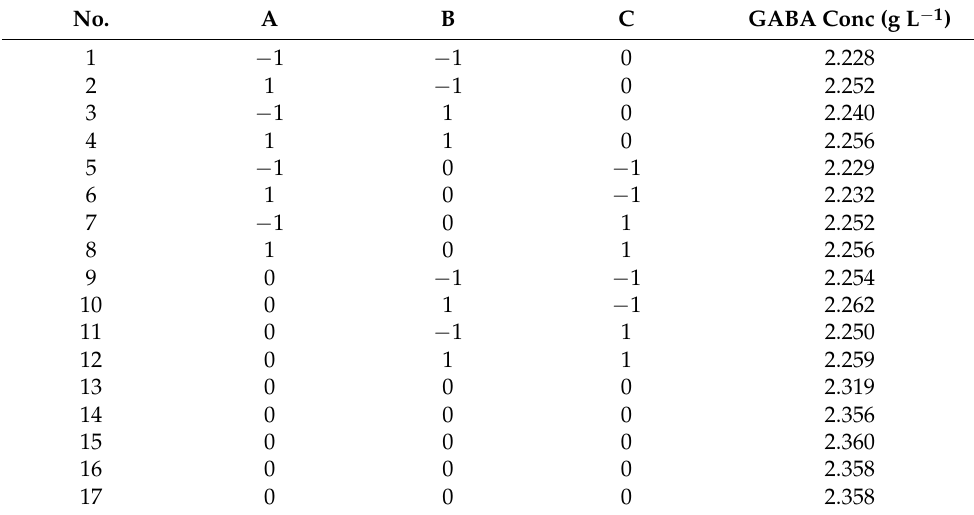
Table 2. Experimental design of Box-Behnken and corresponding results.